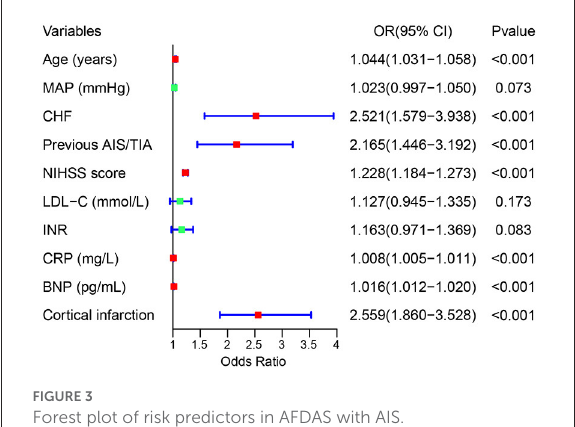
TABLE 3 Risk factors and development of predictive models for AFDAS in training cohort.